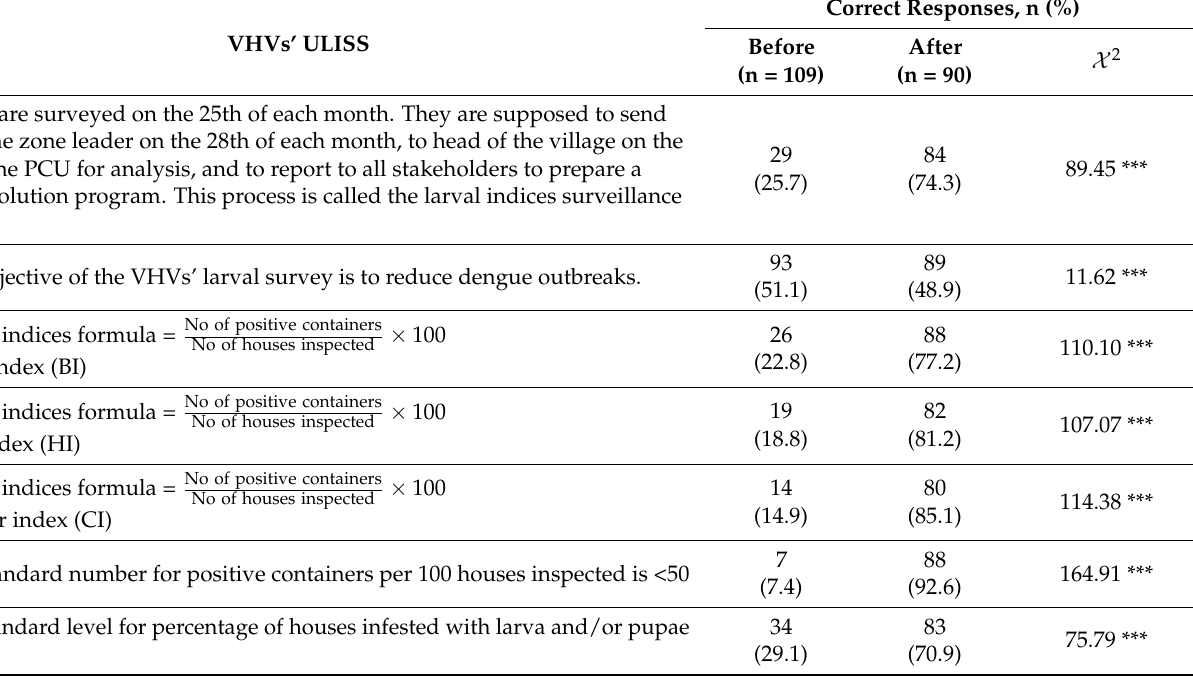
Table 5. Correct response rates regarding the ULISS for VHVs before and after implementation of the training